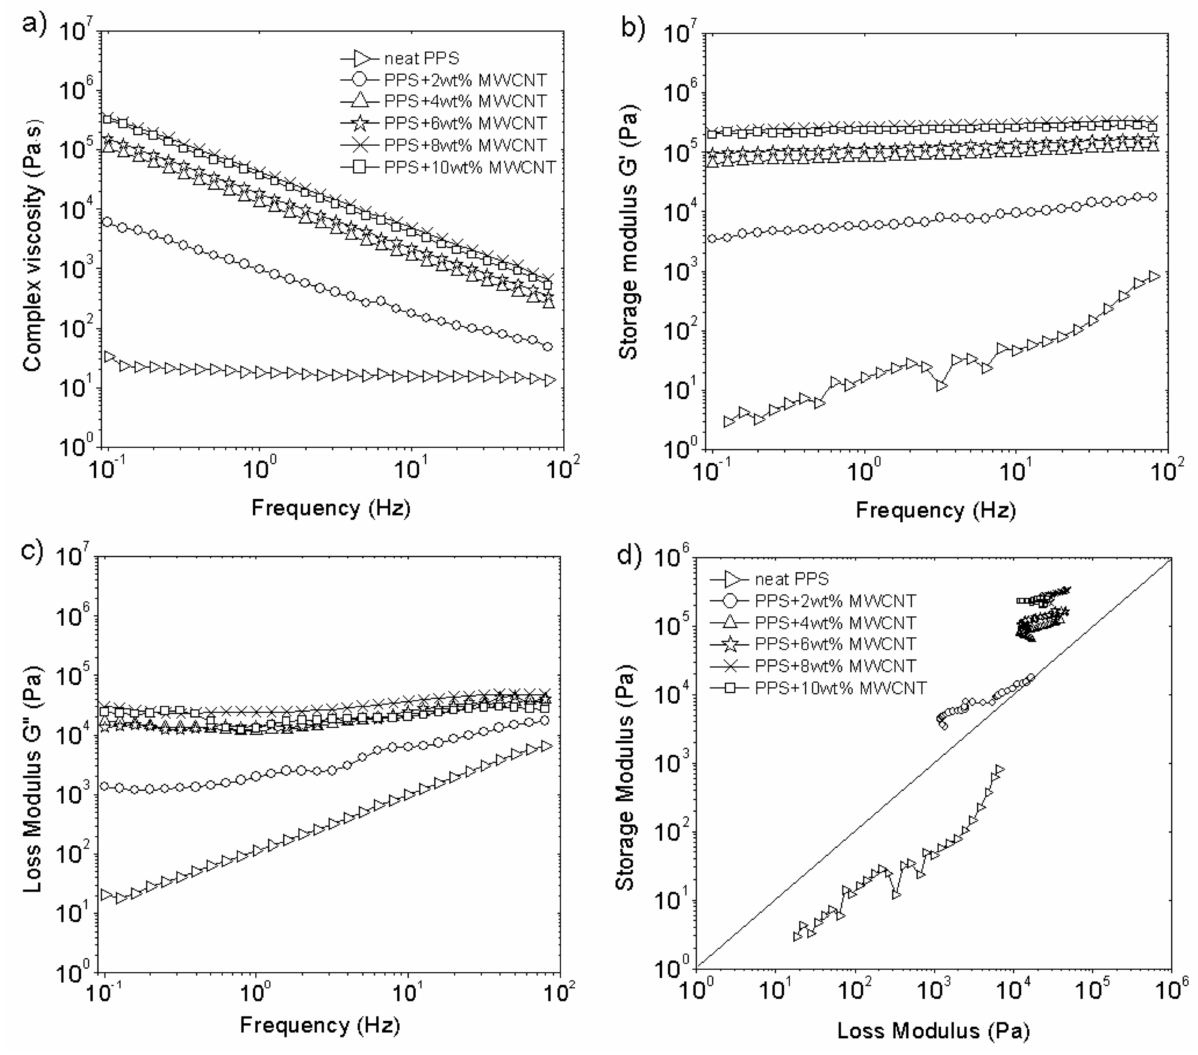
Figure 1. Rheological properties of PPS/MWCNT composites: ( a ) complex viscosity as a function of frequency; ( b ) storage modulus as a function of frequency; ( c ) loss modulus as a function of frequency, ( d ) Cole-Cole plot. The test was performed at 320 ◦ C with 10%